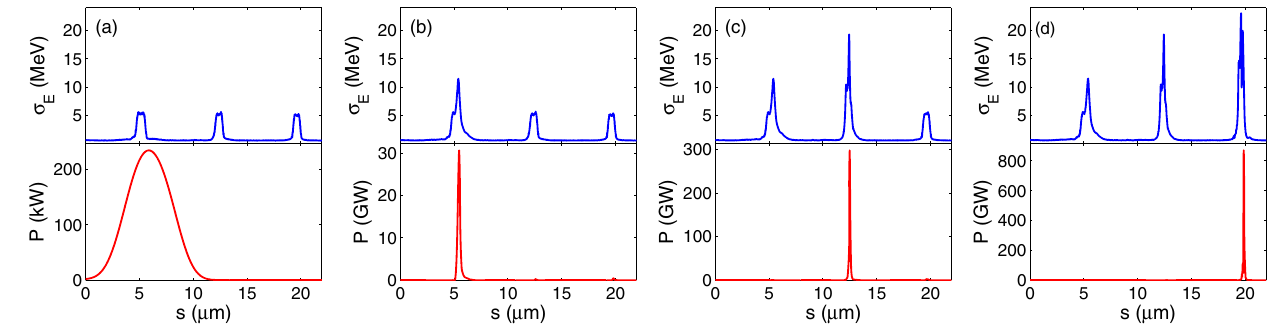
FIG. 3. Simulation results of rms electron energy spread (upper) and FEL power profile (lower) right after the bypass chicane (a) and U2A (b), U2B (c), and U2C (d) undulators. The electron bunch head is to the right. The three high energy spread regions in (a) correspond to the three currents spikes from the center to the right in Fig.